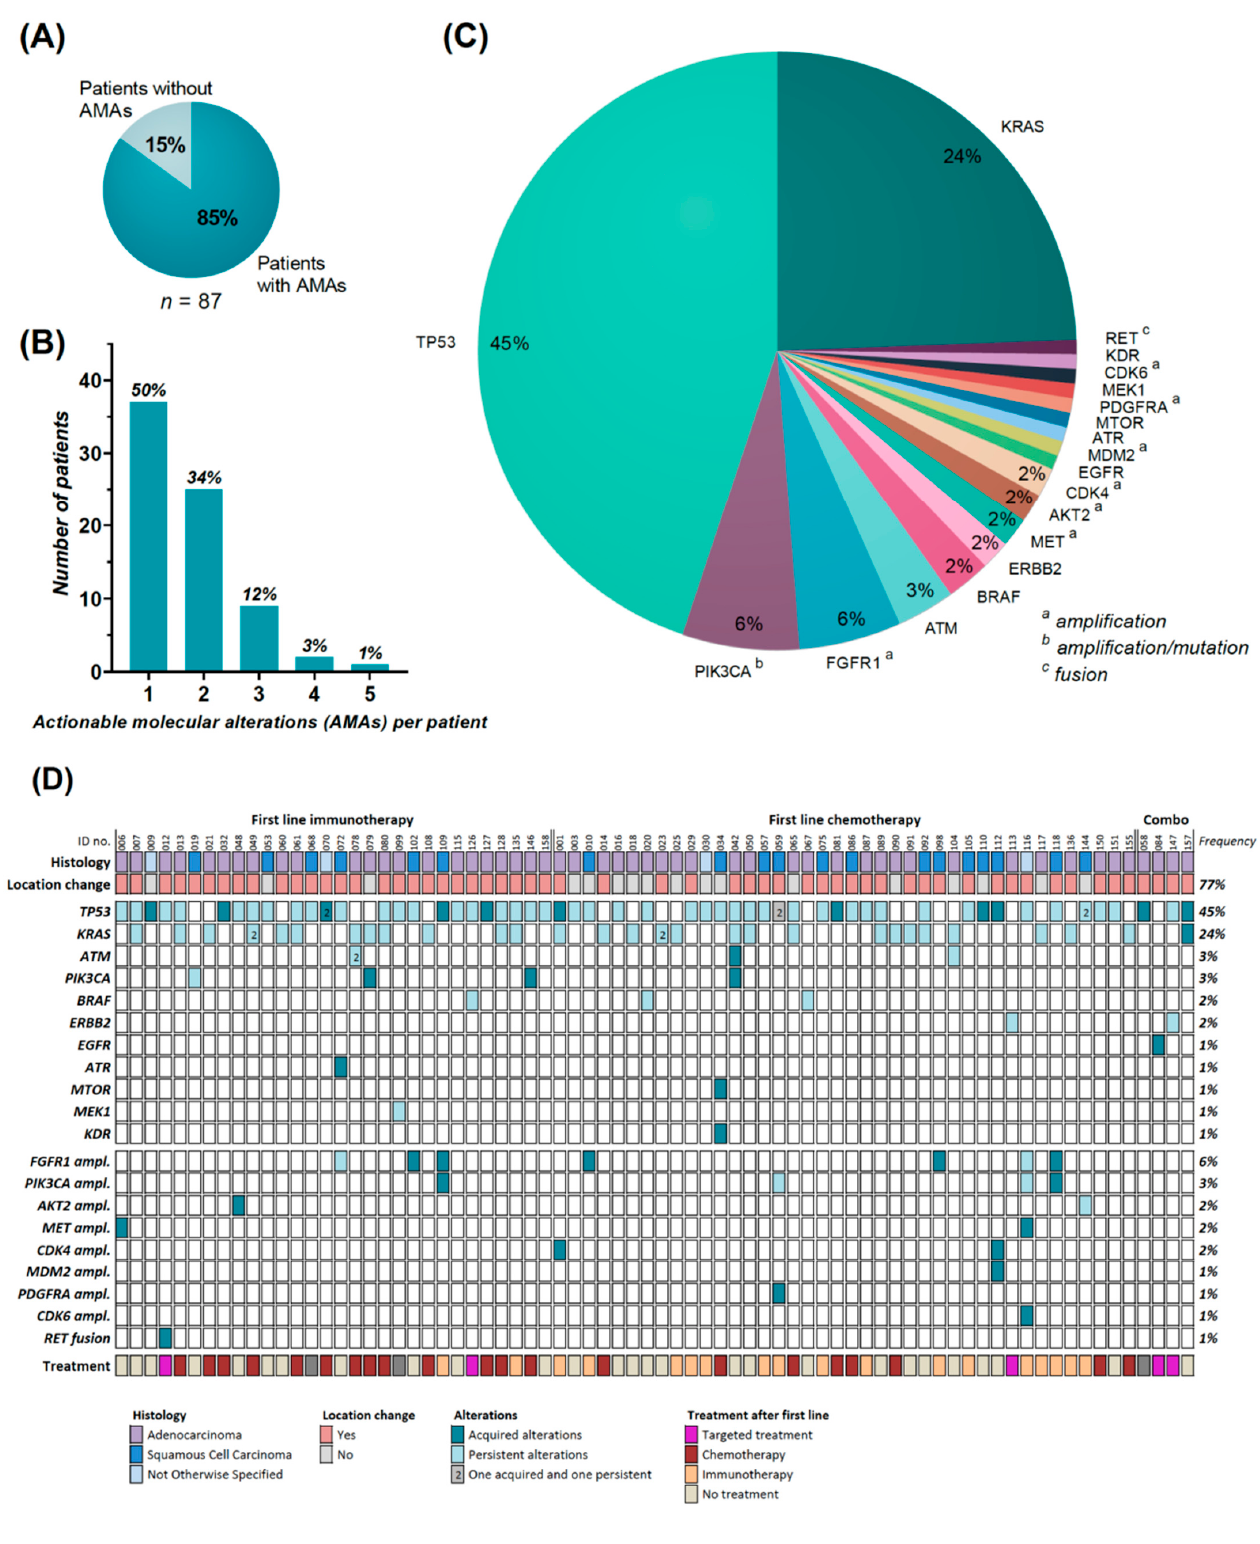
Figure 2. ( A ) illustrates the distribution of patients with or without Actionable Molecular Altera- tions (AMAs). ( B ) illustrates the number of AMAs per patient. ( C ) shows the frequencies of the AMAs. ( D ) illustrates for each patient (columns): Histology of the diagnostic biopsy, occurrence of location changes between the diagnostic biopsy and re-biopsy, molecular alterations, and type of second line treatment.